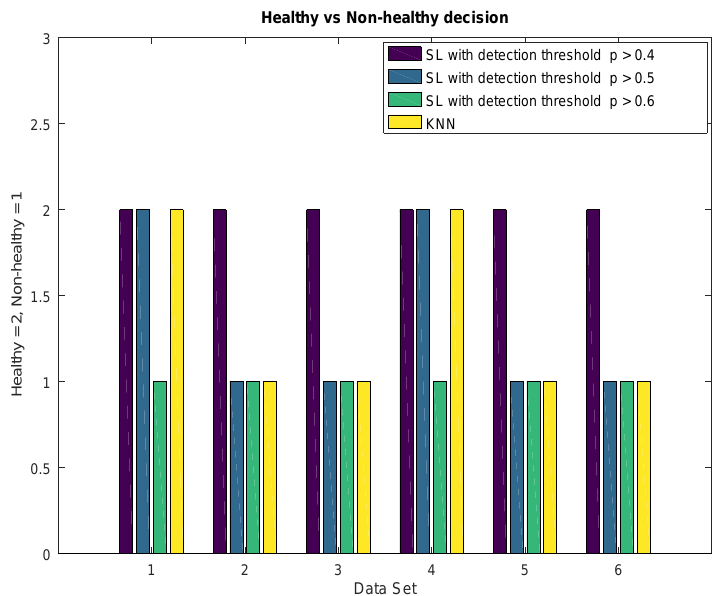
Figure 14. Comparison of KNN vs. subjective logic with varying threshold